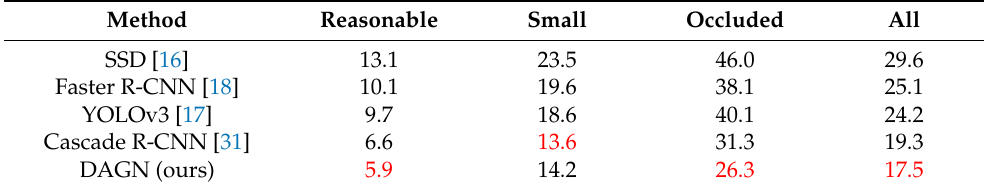
Table 5. Comparisons with the state-of-the-art methods in terms of log average miss rate on the ECP test set. Red color values denote the best